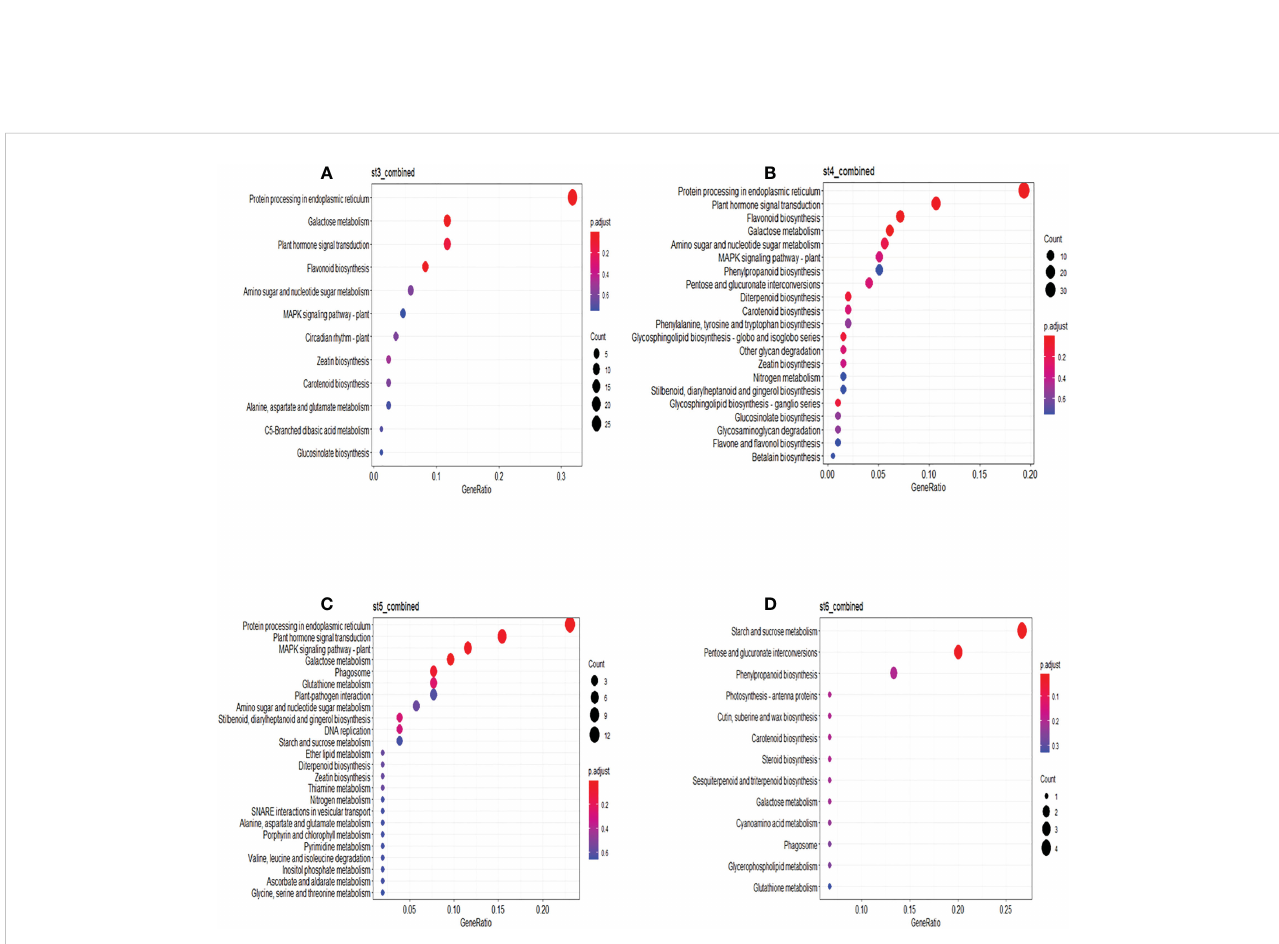
FIGURE 8 KEGG Functional enrichment analysis of DEGs identi fi ed. KEGG functional enrich analysis of differentially expressed genes under combined treatment at different sampling time points; (A) sampling time 3; (B) sampling time 4; (C) sampling time 5; (D) sampling time 6. Signi fi cantly enriched pathways are with adjusted p-value <